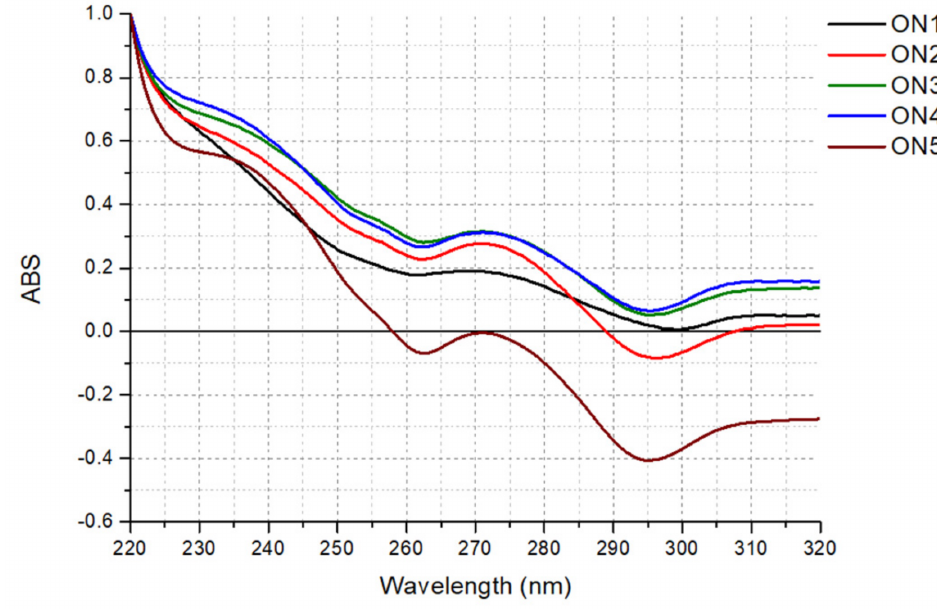
Figure 3. Normalized thermal difference spectra of the oligonucleotides ON1 to ON5 studied in buffer containing 100 mM KCl, 20 mM sodium cacodylate and 0.5 mM Na2EDTA (pH